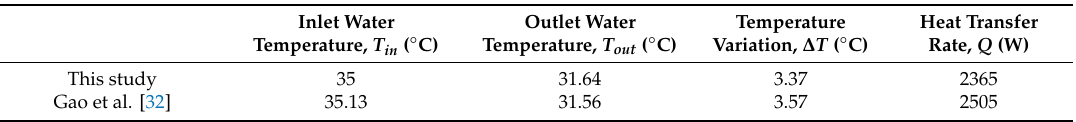
Table 3. Comparison of the outlet water temperature after 3 h of cooling between the present study and Gao et al.’s experiment [32]. Reprint with permission [4942930442751] from Applied Thermal Engineering; published by Elsevier, Dec.